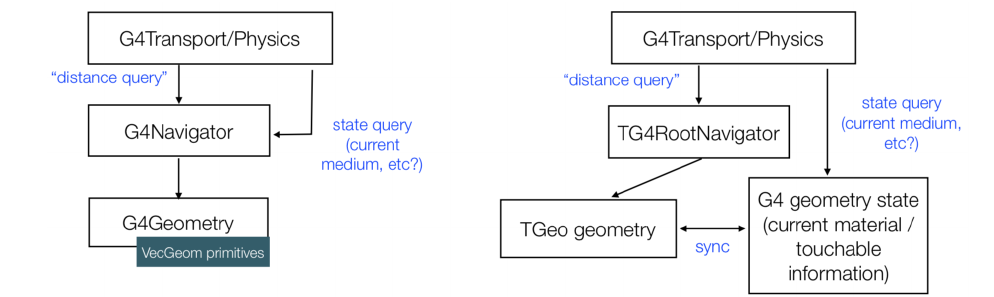
Figure 1. (Left:) Currently, Geant4 is able to dispatch to VecGeom only at the solid primitives level and the Geant4 navigator does not know about this integration. VecGeom solids are hidden behind facade classes looking like Geant4 native types. (Right:) Visualisation of the scheme in which TGeo was integrated into Geant4 [13] as part of the VMC project: A special navigator class was hooked into Geant4. Duplication of geometry and syncronisation of state is necessary due to di ff erent type system of Geant4 and